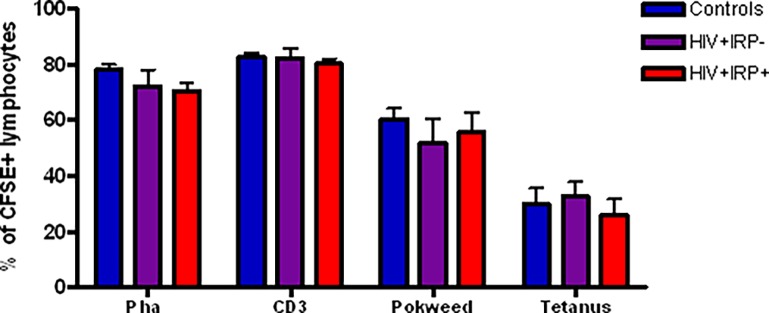
Relationship between the IRP and proliferative capacity.The percentage of carboxyfluorescein succinimidyl ester (CFSE) positive cells was used to assess the proliferative capacity of lymphocytes after stimulation with phytohemagglutinin, (PHA), anti-CD3 and-CD28, Pokeweed mitogen and Tetanus toxoid. Comparisons were made between uninfected controls (blue), HIV+IRP- (purple) and HIV+IRP+ (red). Statistical significance was determined using the Mann–Whitney U test. *p<0.05, **p<0.01, ***p <0.001.